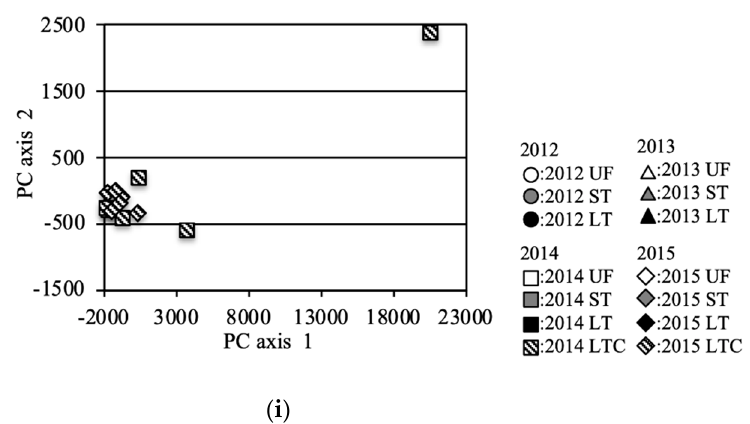
Figure 4. Principal coordinate analysis (PCA) (incremental Euclidean distance) of the OTUs: ( a ): all soil samples, ( b ): soil samples in 2012 (referred to Asano et al. [7]), ( c ): soil samples in 2013, ( d ): soil samples in 2014, ( e ): soil samples in 2015, ( f ): sample in UF, ( g ): sample in ST, ( h ): sample in LT, ( i ): sample in LTC. b (2012), c (2013), e (2015) f (UF), g(ST), and h (LT) show the area enclosed by the dotted line in a (all soil samples).